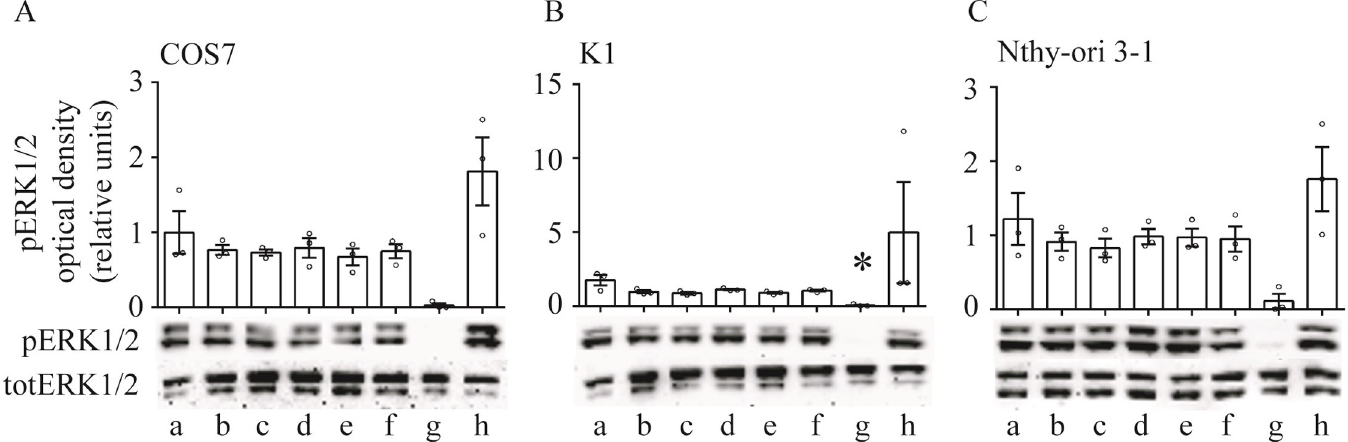
Fig 3. 15-min, 8-Br-cGMP/vardenafil-induced ERK1/2 phosphorylation in the three cell lines. Cells were treated as follow: a) untreated; b) 10 μ M 8-Br-cGMP; c) 50 μ M vardenafil; d) preincubation with NS 2028 (GCi) and treatment with 8-Br-cGMP; e) preincubation with NS 2028 (GCi) and treatment with vardenafil; f) NS 2028 (GCi); g) MEK inhibitor U0126 was used to deplete ERK1/2 phosphorylation h) PMA was used as positive control of pERK1/2. Data from densitometric analysis were compared by Kruskal Wallis test and Dunn’s post-test ( � significantly different versus untreated samples; p � 0.05; means ± SEM were superimposed to data points; n =